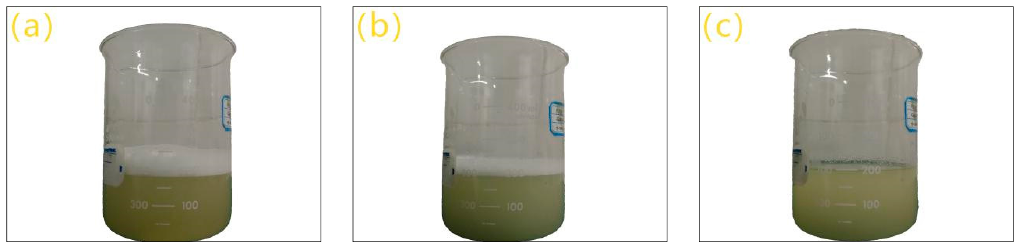
Figure 6. The basic fluid is added with 0.10% ( a ) TX-10, ( b ) HSB1618 and ( c ) penetrant T.